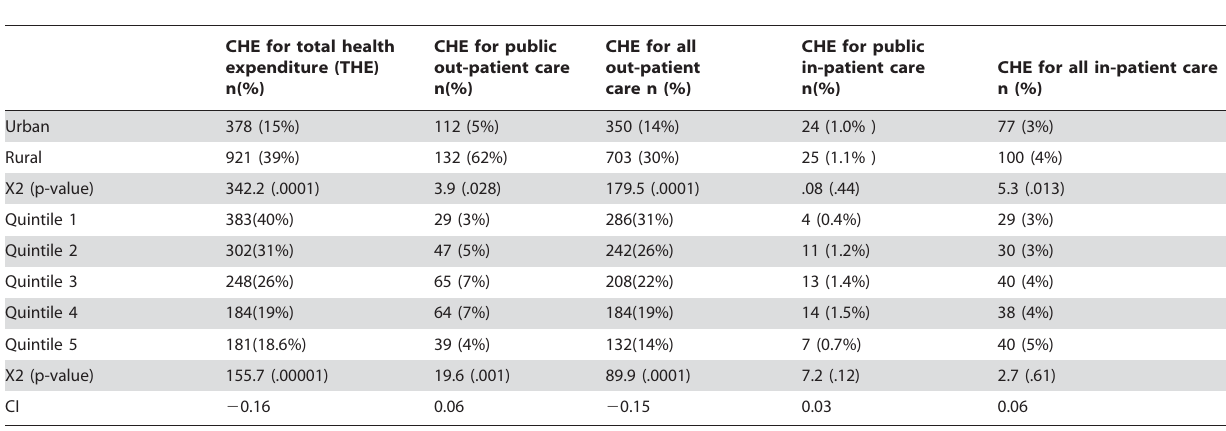
Table 4. Number of households from different population groupings with catastrophic health expenditures for different services and